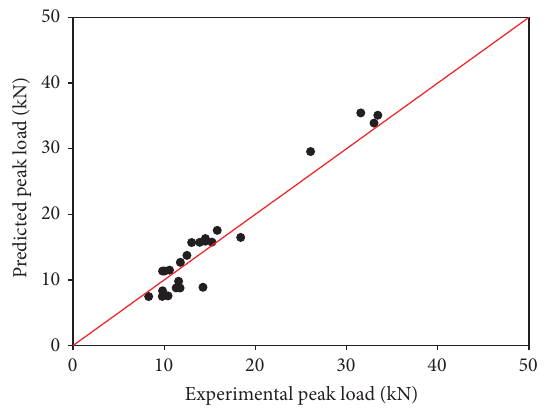
Figure 13: Comparison between predicted and experimental ulti- mate pull-out loads at 0, 6, 12, and 18 months taking all the 6 FRP